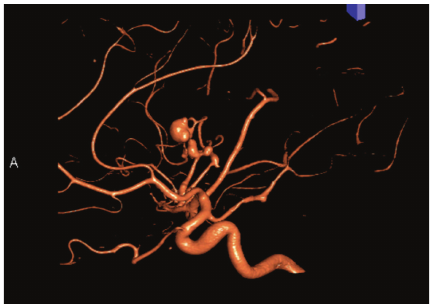
Figure 2: Lateral CTA scans demonstrating an ectatic fusiform dilatation of the involved MCA distal branch with aneurysm. In addition, a saccular smaller aneurysm at the origin of MCA bifurcation and another fusiform smaller aneurysm at the first segment of PCA were demonstrated.